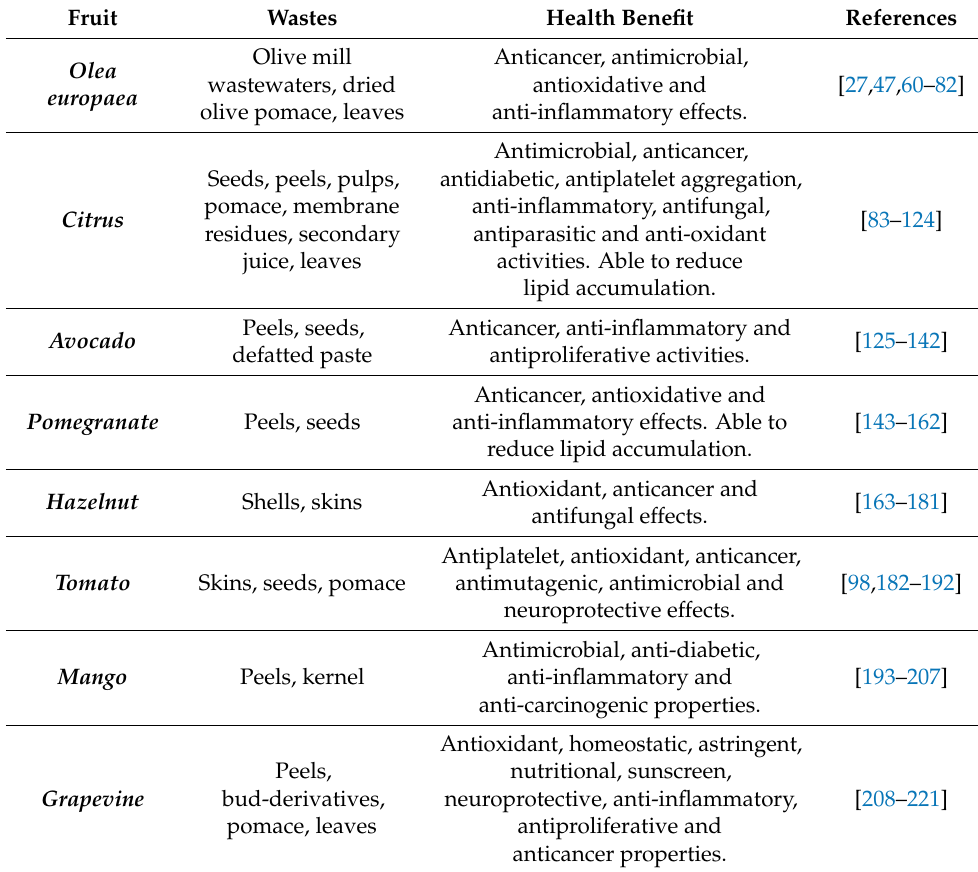
Table 2. Health benefits of fruit